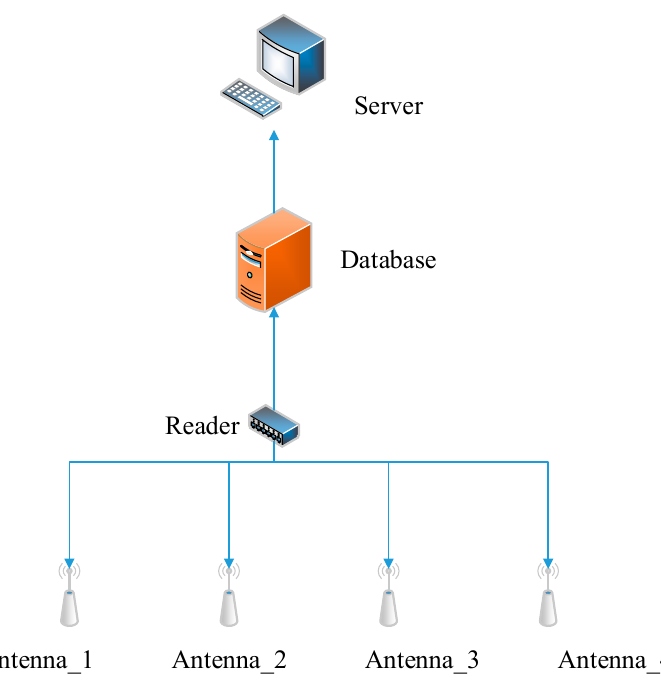
Figure 5. Block diagram of the RFID information acquisition module.